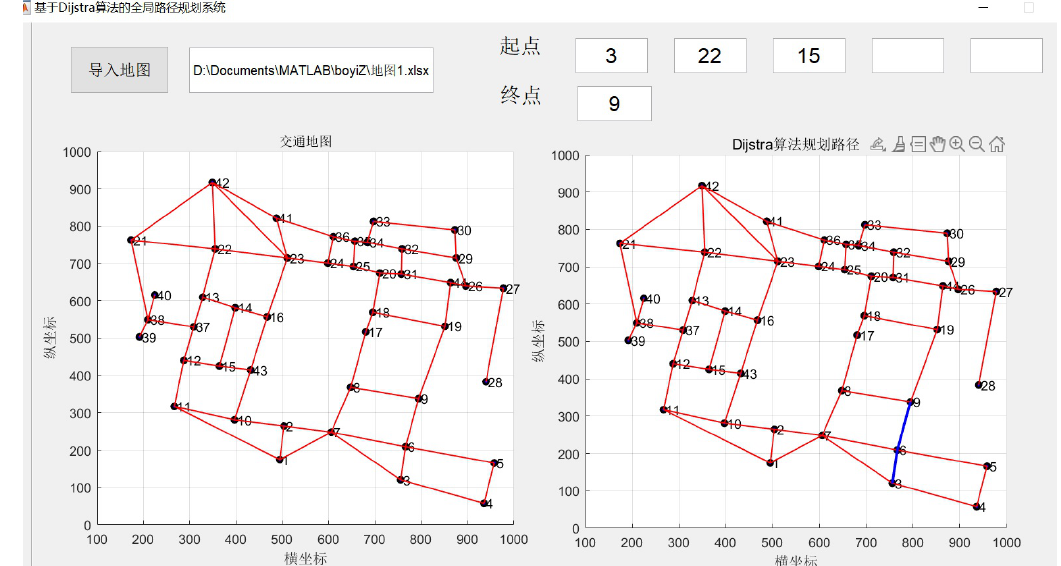
Fig. 6 When m = 3, the shortest path planning is shown as blue